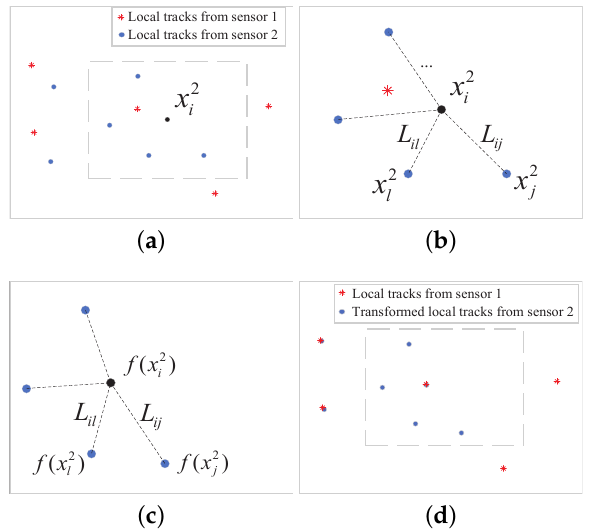
Figure 2. Schematic illustration of the geometrical constraint. ( a ) with local tracks from sensor 1 and 2, assign neighbors to each local track from its sensor, e.g., the four local tracks around x i 2 ( b ) compute the weights L ( c ) perform the transformation f with the constraint that each local track x i 2 be reconstructed by its neighbors with weights L after the transformation ( d ) align the Local tracks from sensor 1 and 2 after transformation f by maximizing the objective